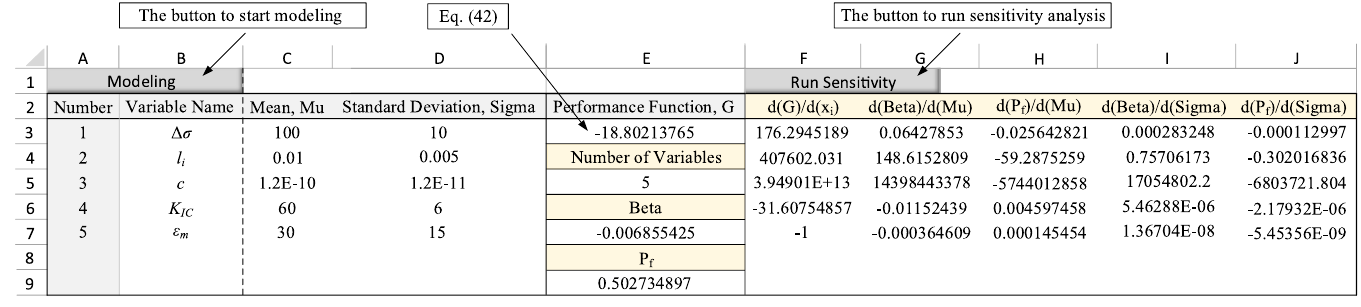
Fig 9. Sensitivity derivatives for the second example considering the model